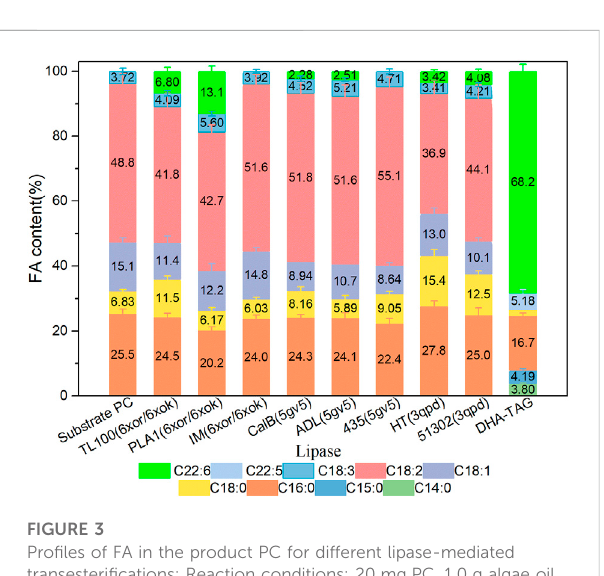
FIGURE 3 Pro fi les of FA in the product PC for different lipase-mediated transesteri fi cations; Reaction conditions: 20 mg PC, 1.0 g algae oil, lipase (10 µL for liquid lipases and 20 mg for immobilized lipases), 45 ° C, 500 rpm, 1 h.